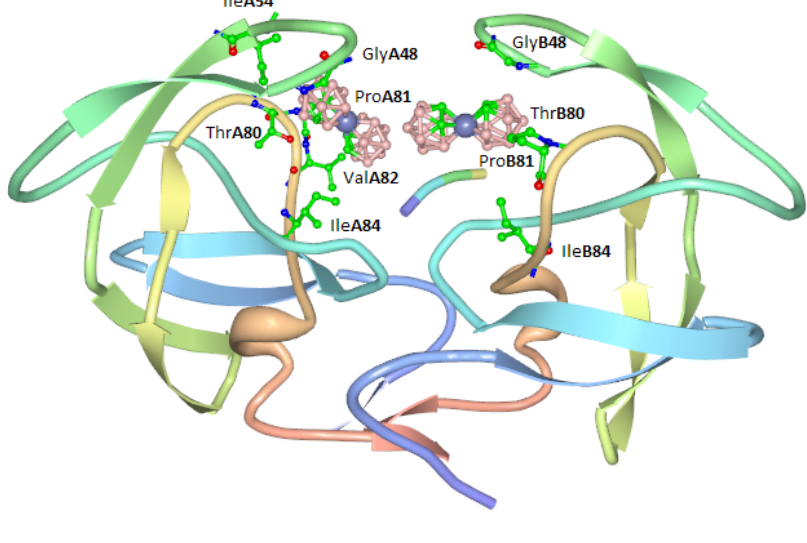
Figure 5. Interaction of compound 3 with hydrophobic binding pocket of HIV